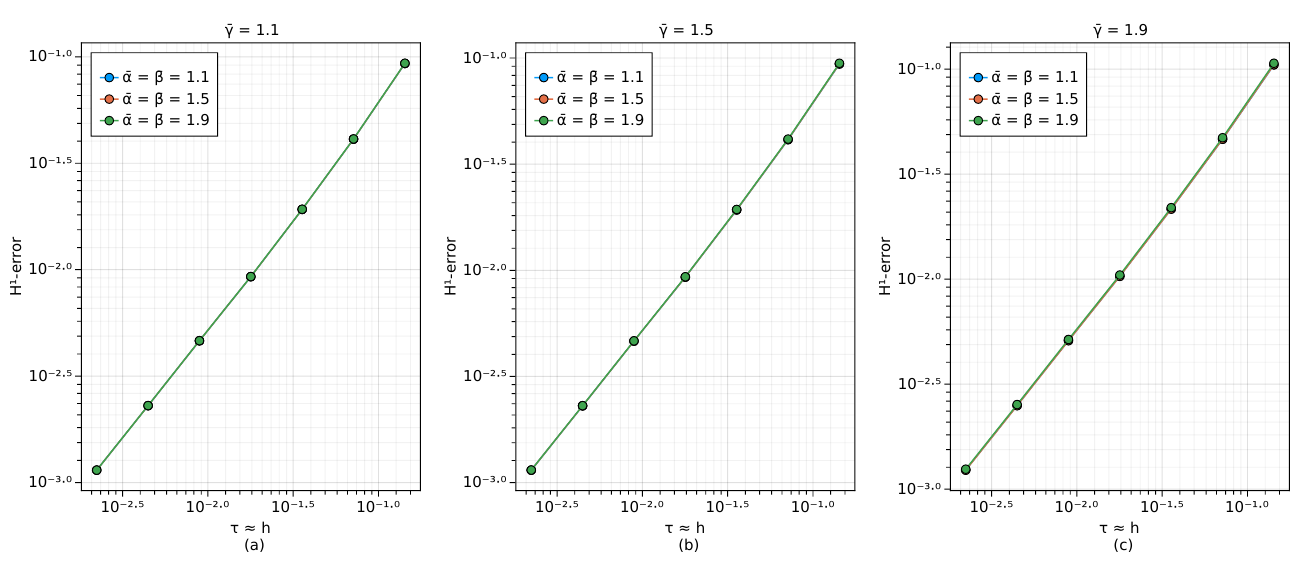
Figure 2. Error plots for E 2 calculated by (55) with respect to τ ≈ h obtained for different orders of N fractional derivatives: α ∈ { 1.1,1.5,1.9 } ; β = α ; ( a ) γ = 1.1; ( b ) γ = 1.5; ( c ) γ =